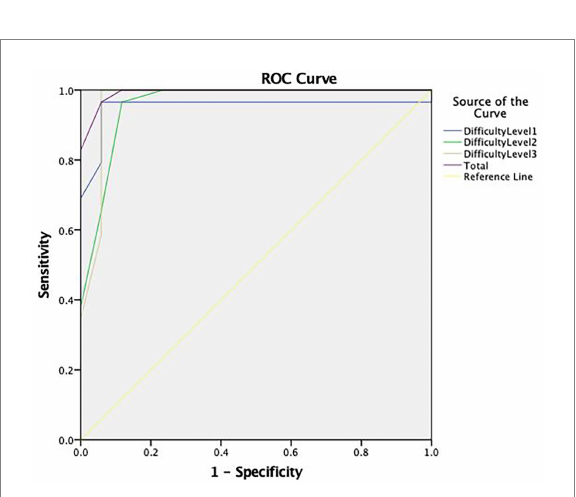
FIGURE 4 ROC curve concerning the discriminative capacity of the Coin in Hand—Extended Version (CIH-EV).